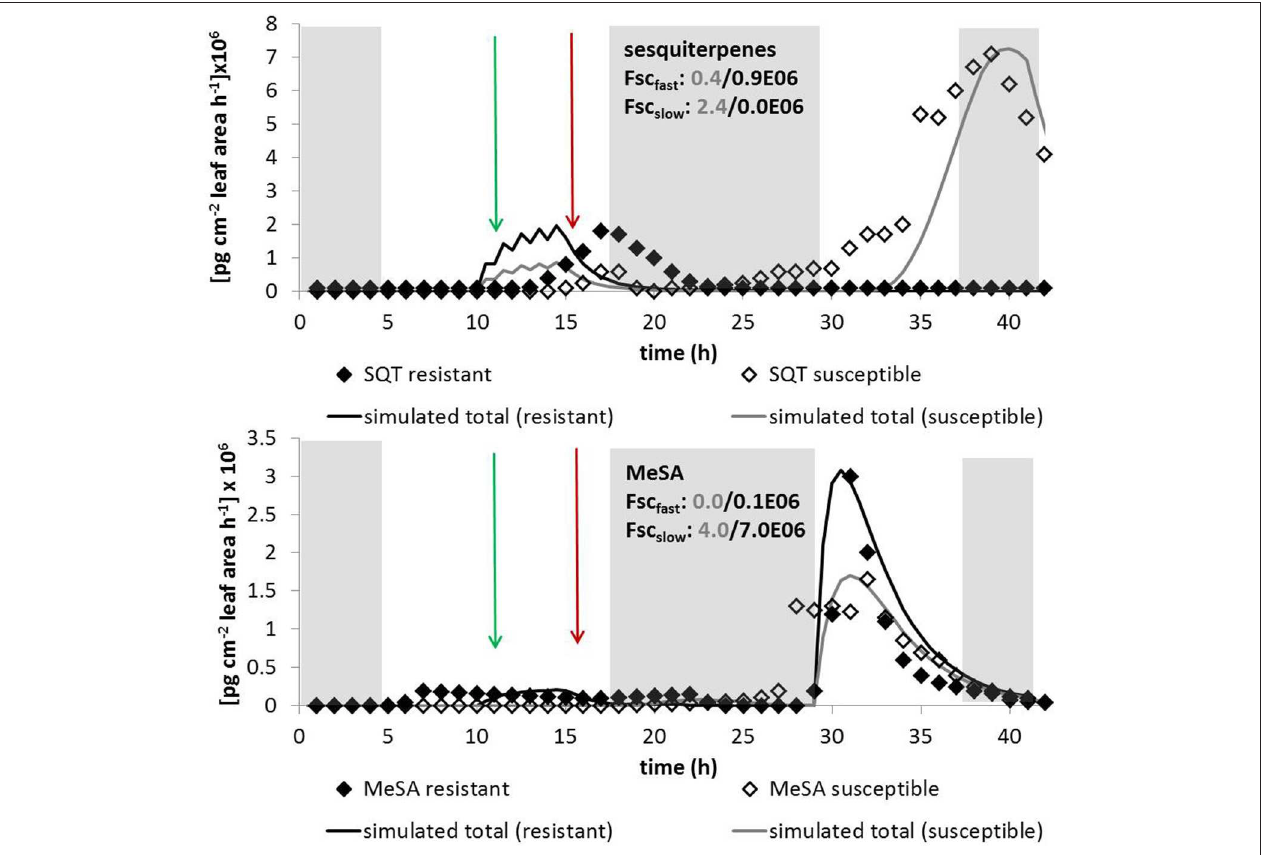
FIGURE 6 | Simulated and measured emissions of the sesquiterpene valencene (top) and MeSA (bottom) for susceptible (gray lines and open symbols) and stress tolerant variants (black lines and closed symbols). Data are taken from Heiden et al. (1999) measured at tobacco plants ( Nicotiana tabacum ) exposed to ozone. Shaded areas denote dark periods without de-novo biosynthesis; green arrows show the start and red arrows the end of the fumigation. Indicated scaling parameters are given for 1-h induction cycles; for other parameters see Table 1